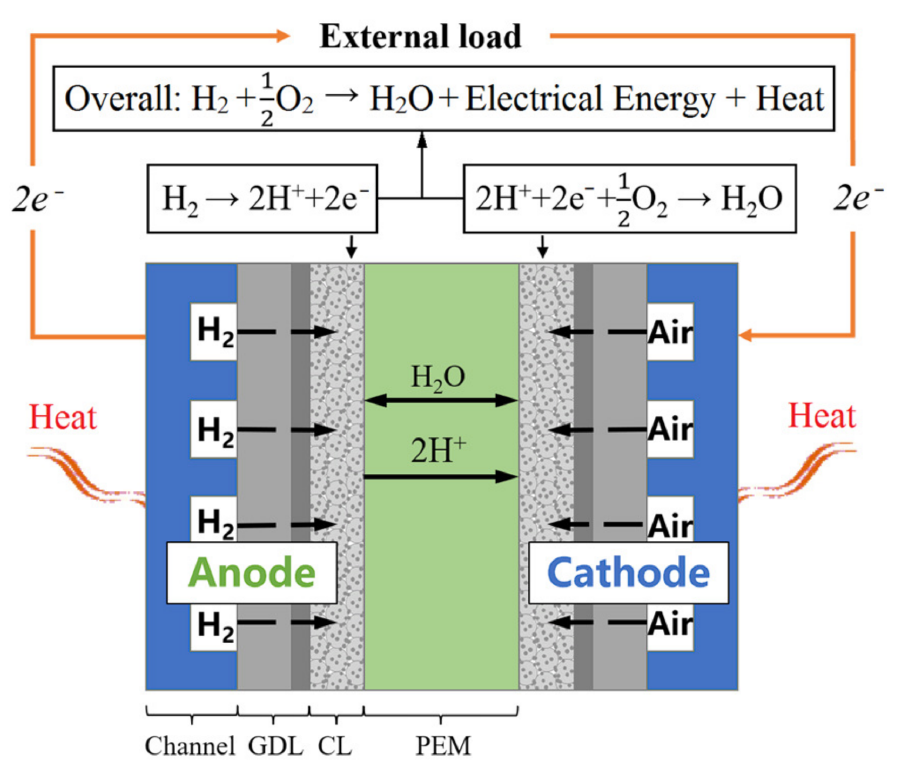
Figure 1. Schematic diagram of a single PEMFC